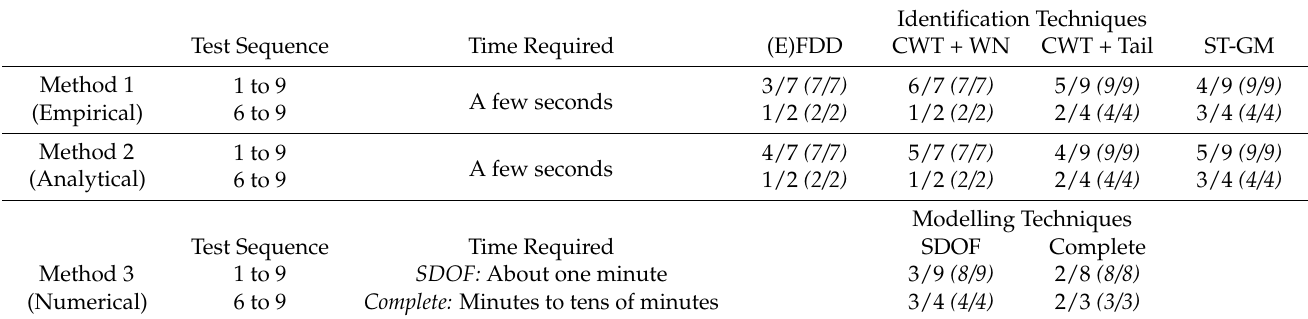
Table 4. Comparison of EMS-98 DG estimations from empirical, analytical, and numerical methods. DG estimations with ± 1 accuracy limits are reported in parenthesis “ ( ) ” and italic